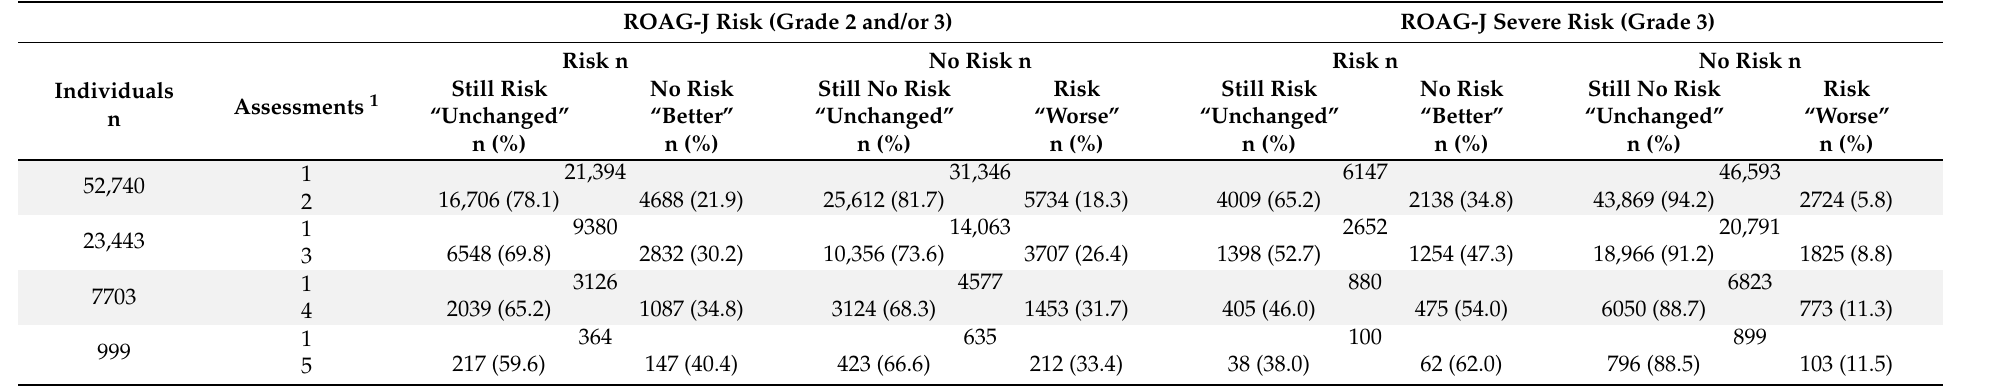
Table 6. Number of individuals in nursing homes who received two to five annual ROAG-J assessments (2011–2016). Frequency and percentage of individuals who had risk in the first assessment and became “better” (no risk in ROAG-J in the last assessment), and those who had no risk in the first assessment and became “worse” (risk in ROAG-J in the last assessment), and those who were “unchanged” (still had risk or still had no risk in the last